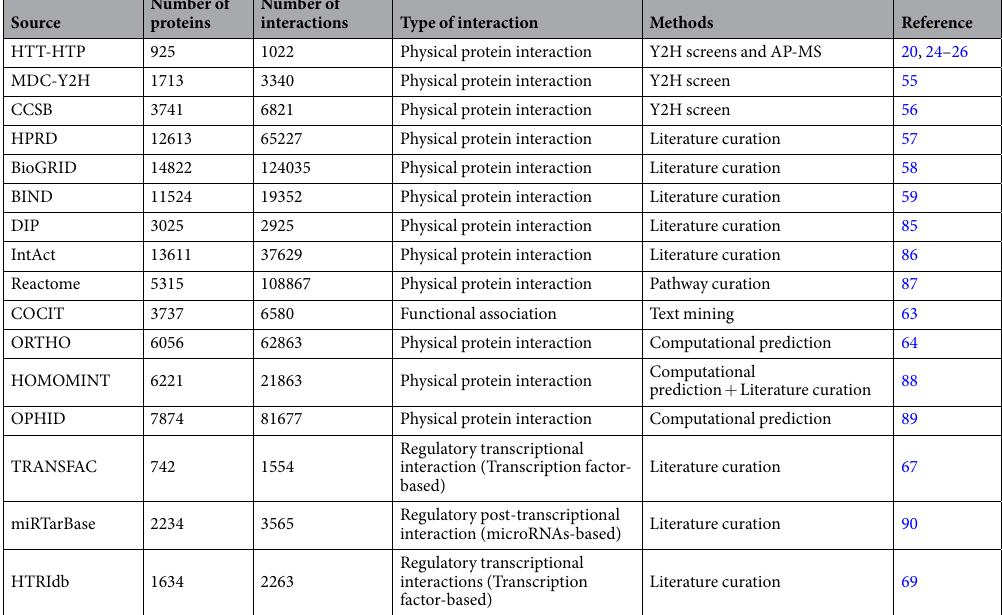
Table 1. Molecular interaction datasets integrated in HDNetDB. The source, number of imported proteins and interactions, type of interaction and methodology used for original identification of the interactions as well as the reference are listed.